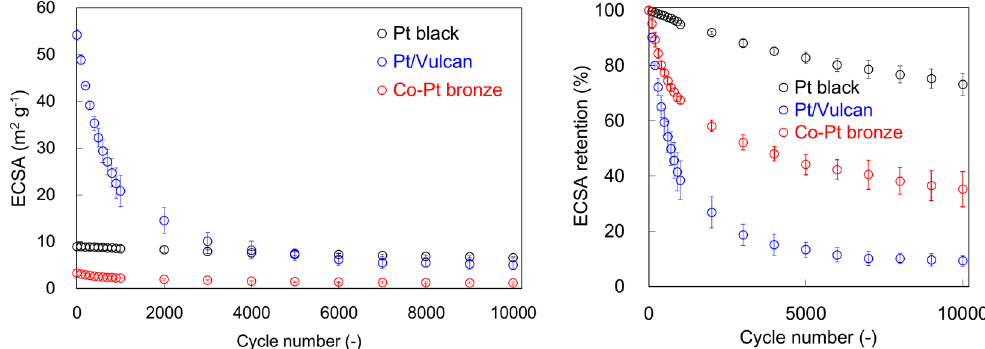
Figure 14. ECSA retention during potential cycle accelerated durability test.